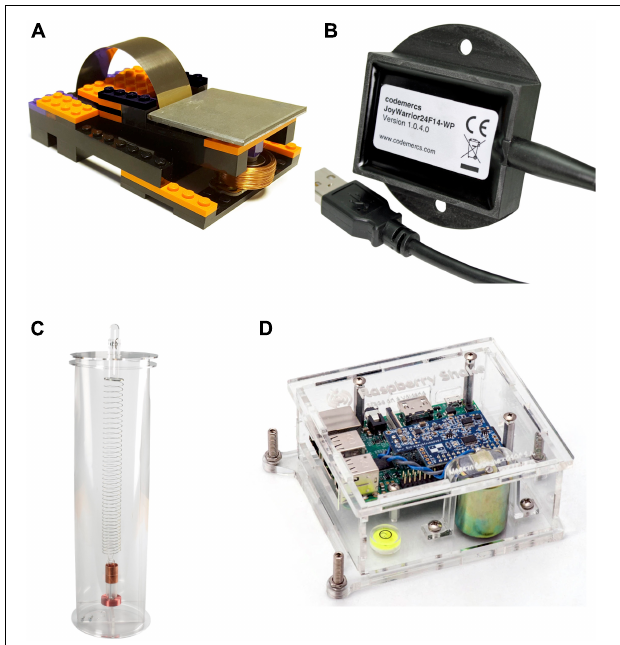
FIGURE 4 | Low-cost sensors purchased and tested before selecting one for our program: (A) Lego, (B) Quake Catcher, (C) Slinky, (D) Raspberry Shake 1D. See Table 2 for the characteristics of each sensor and our